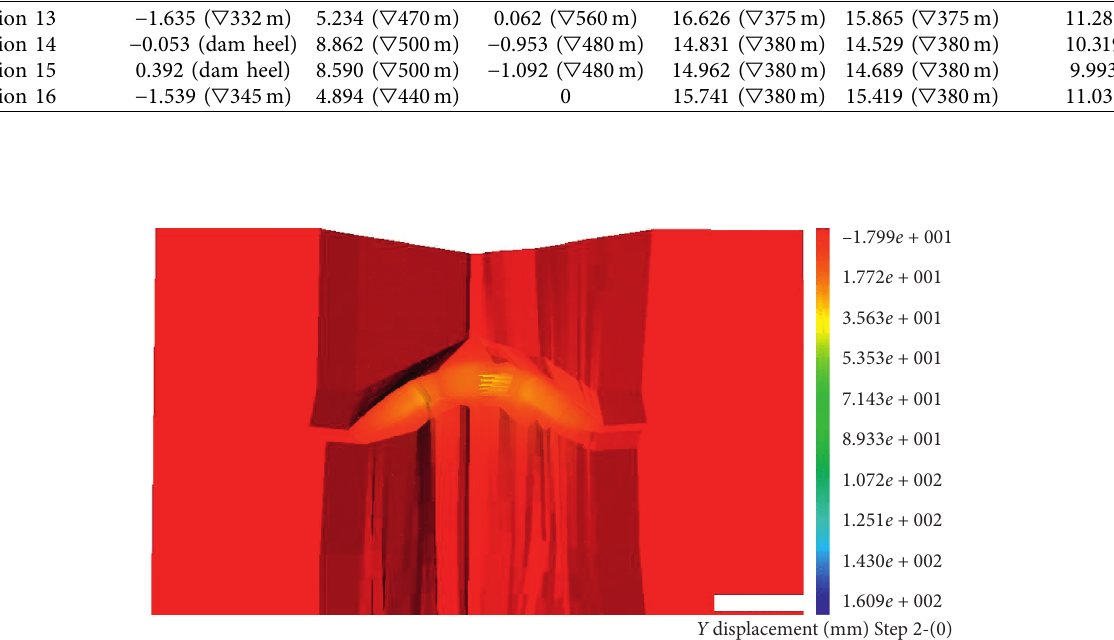
Figure 9: Displacement of foundation along the river in working condition 4 (unit: